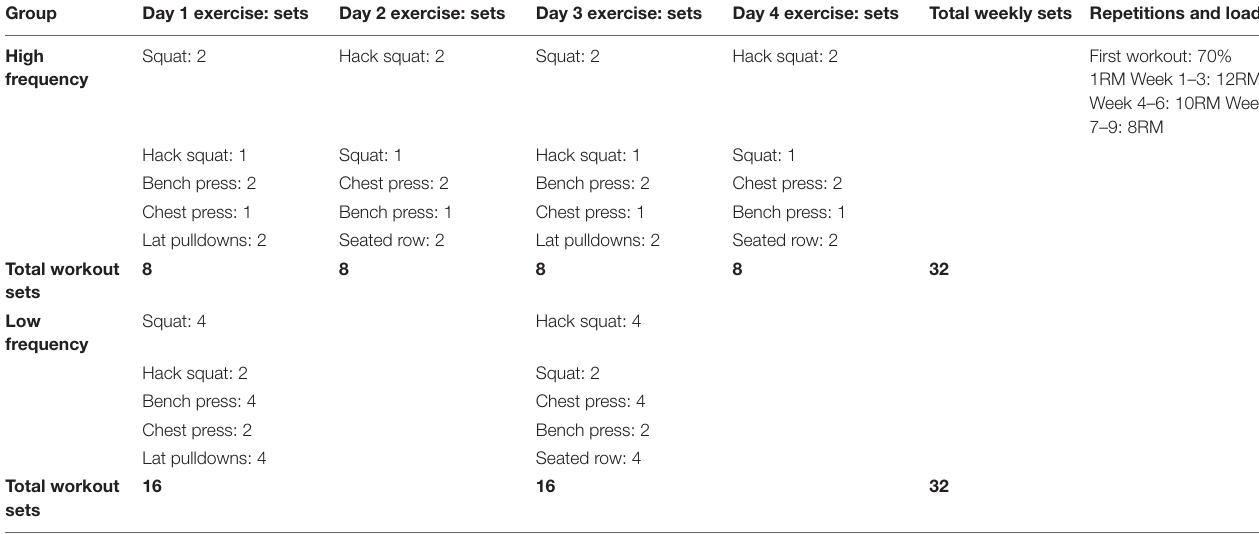
TABLE 1 | Training protocol.